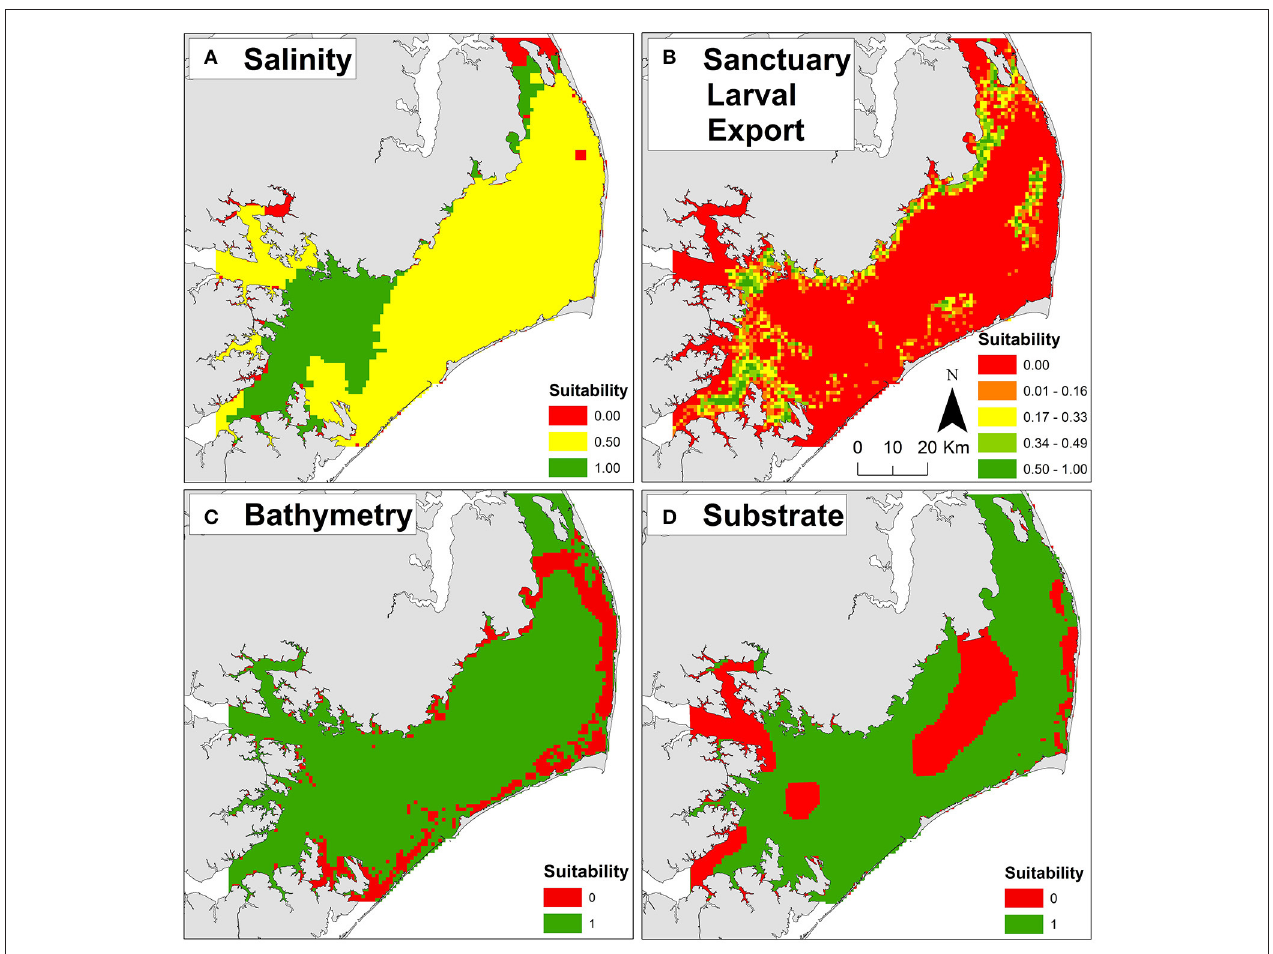
FIGURE 3 | Example threshold and exclusion layers used to compute habitat suitability for oyster sanctuary restoration. (A) Salinity threshold layer. (B) Sanctuary larval export threshold layer. (C) Bathymetry exclusion layer. (D) Substrate exclusion layer. Suitability scores of zero (red) are unsuitable and one (green) are optimal for each layer. For additional layer details, see Table 1 and Appendices 1, 2 in Supplementary